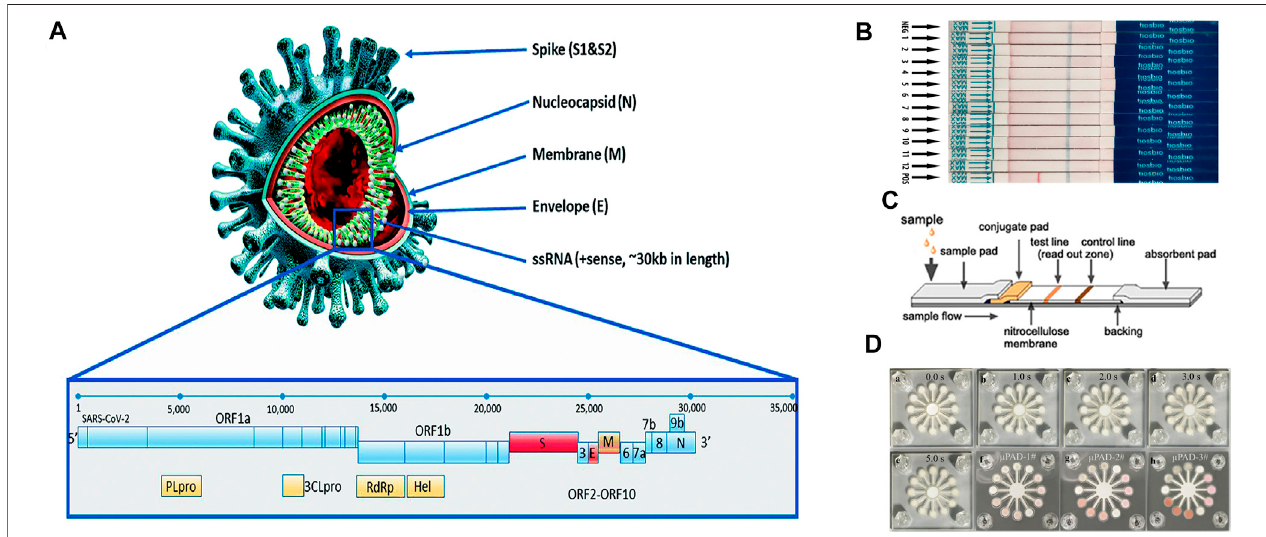
FIGURE 1 | (A) Structural proteins of SARS-CoV-2: envelope (E), membrane (M), spike (S), helicase (Hel), and nucleocapsid (N). Adapted with permission from (KubinaandDziedzic,2020)underCreativeCommonslicense; (B) dipstickpapertest.Adaptedwithpermissionfrom(ZhengY.-Z.etal.,2021)underCreativeCommons license; (C) lateral fl ow paper test. Adapted with permission from (He et al., 2016) under Creative Commons license; (D) micro fl uidic paper-based analytical devices. Adapted with permission from (Sun et al., 2019) under Creative Commons